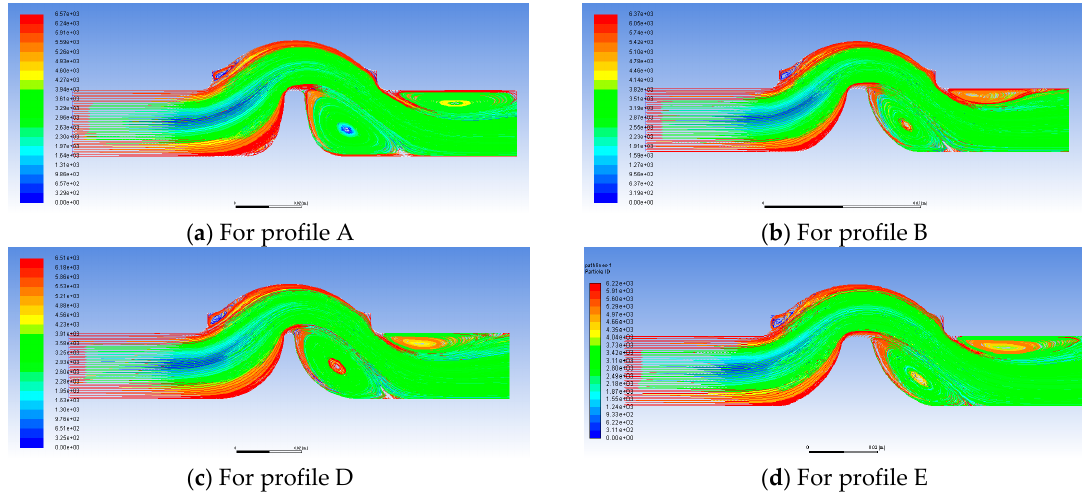
Figure 12. The streamline diagrams of four types of surfaces.